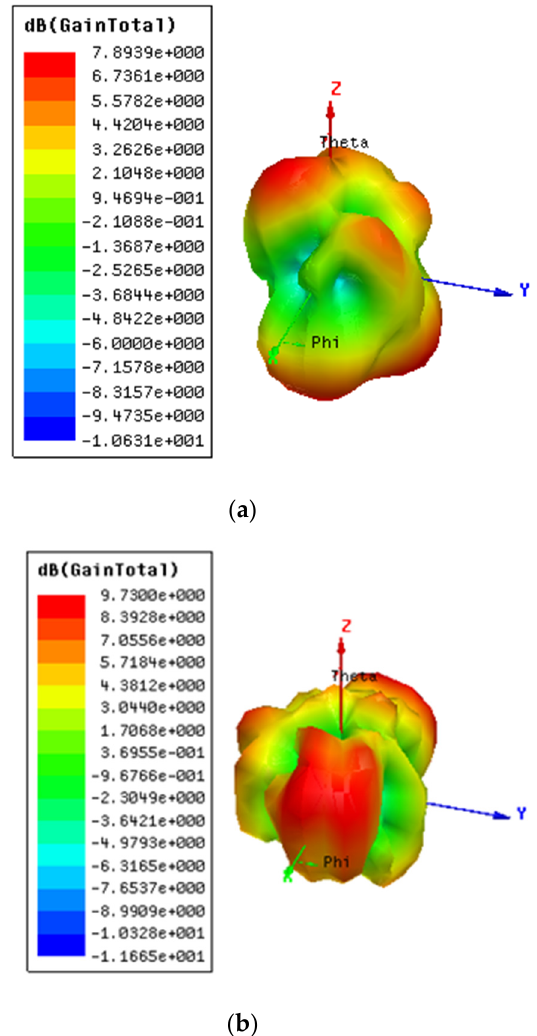
Figure 15. Three-dimensional gain plot for frequencies ( a ) 22.7GHz ( b ) 34.9GHz.